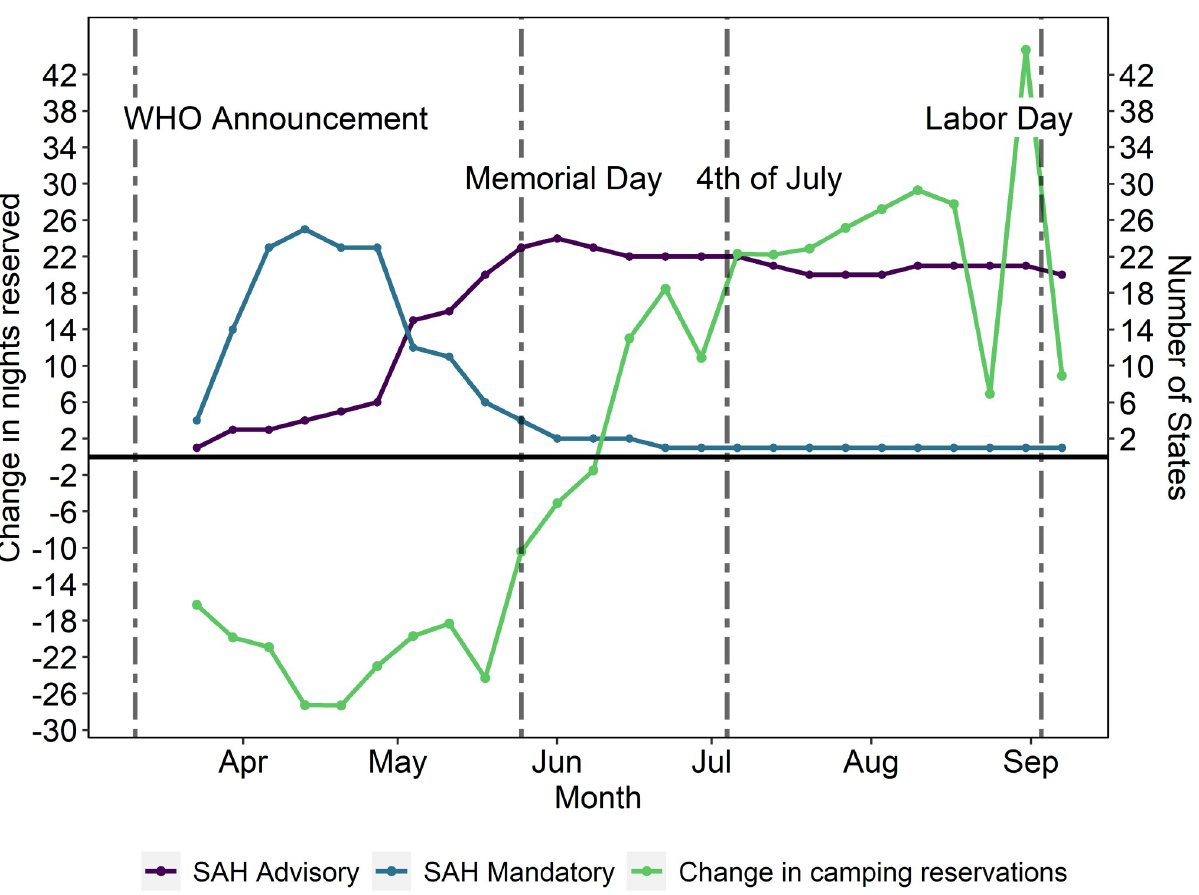
Fig 2. Average change in weekly camping nights reserved by campground between 2020 and 2019 and stay-at-home orders (SAH).